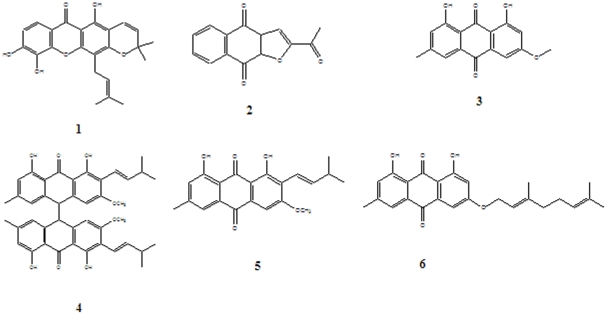
Chemical structures of the studied compounds.
1: xanthone V1, 2: 2-acetylfuro-1,4-naphthoquinone; 3: physcion; 4: bisvismiaquinone; 5: vismiaquinone; 6: 1,8-dihydroxy-3-geranyloxy-6-methylanthraquinone.